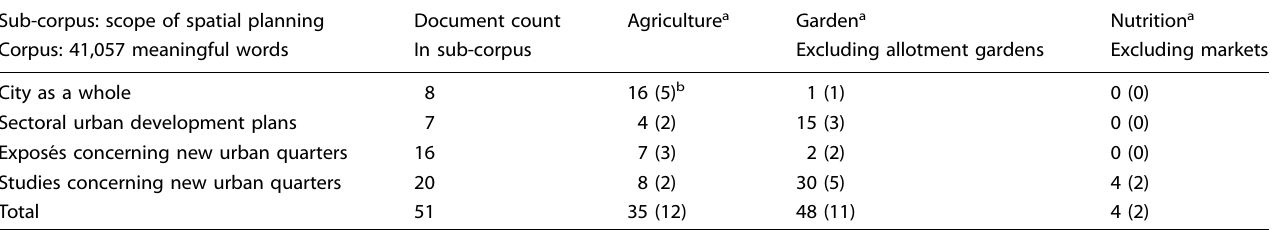
Table 1. Frequency of bigrams containing agriculture, garden or nutrition with at least two mentions in a corpus of selected Berlin spatial planning documents. Sub-corpus: scope of spatial planning